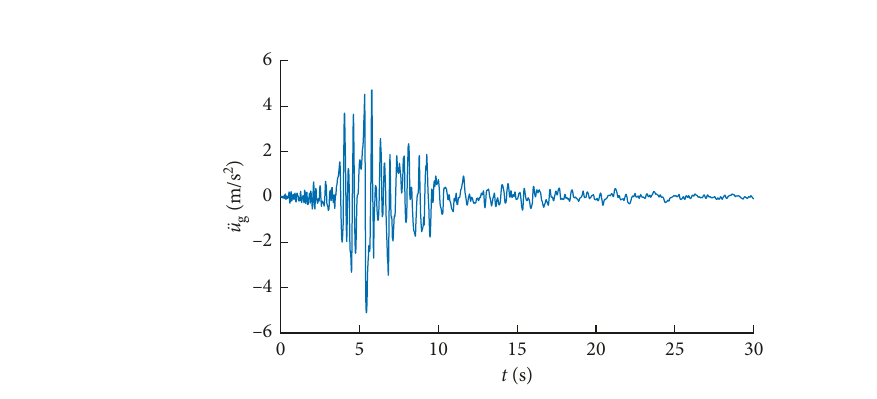
Figure 16: EL Centro record used in the analysis.